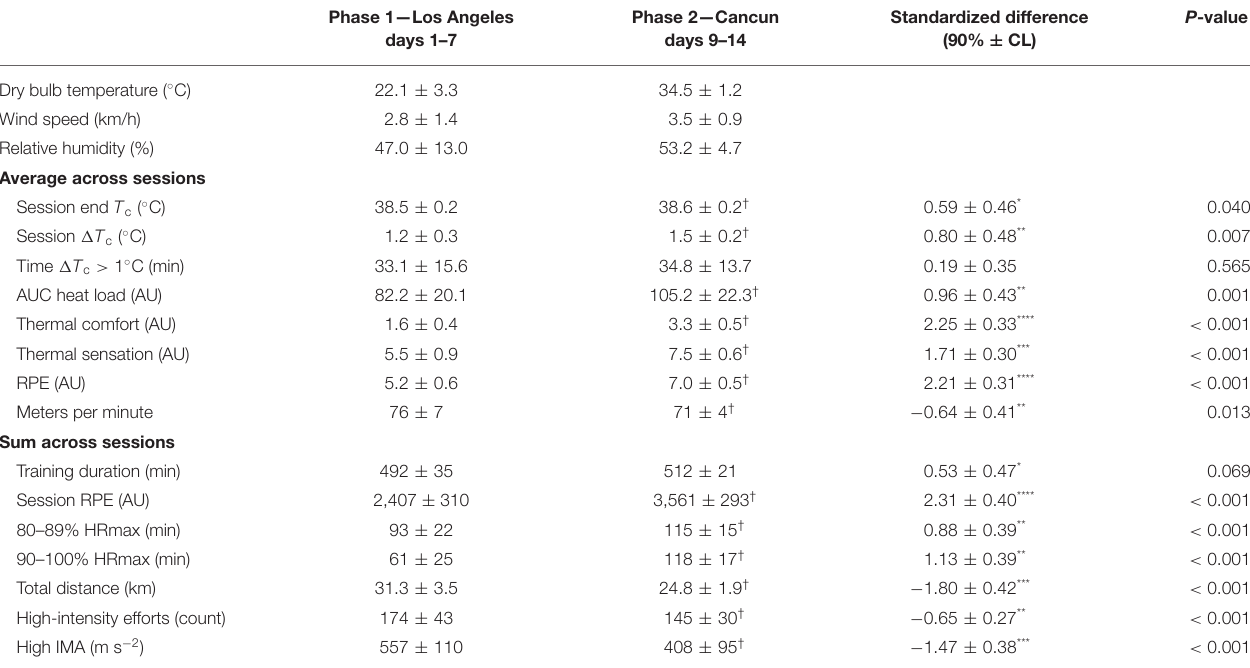
TABLE 1 | Descriptive (mean ± SD) and standardized differences in weather conditions, thermoregulation responses, and training load for the two phases of heat acclimatization.